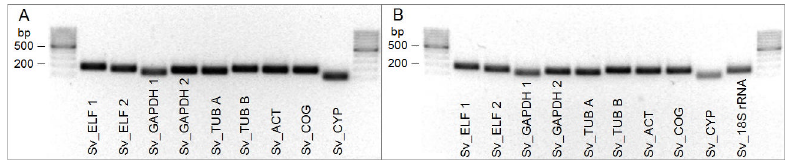
Fig 1. qPCR amplicons generated with cDNA from leaf tissue by the indicated primer pairs. Agarose gel (1.5%) with specific qPCR products of expectedsizes. A : oligo(dT)-primed amplicons; B : random hexamer-primed amplicons.Size standardsare loadedon the left and right sides—GeneRuler100 bp DNA Ladder.